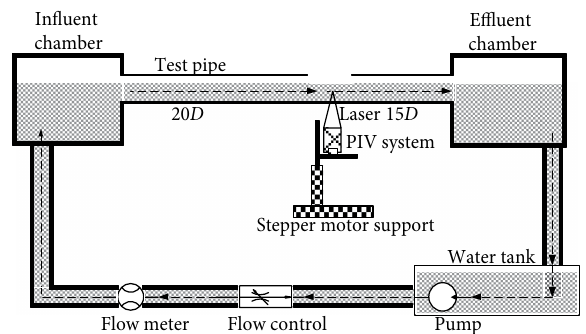
Figure 5: Schematic diagram of the test equipment.